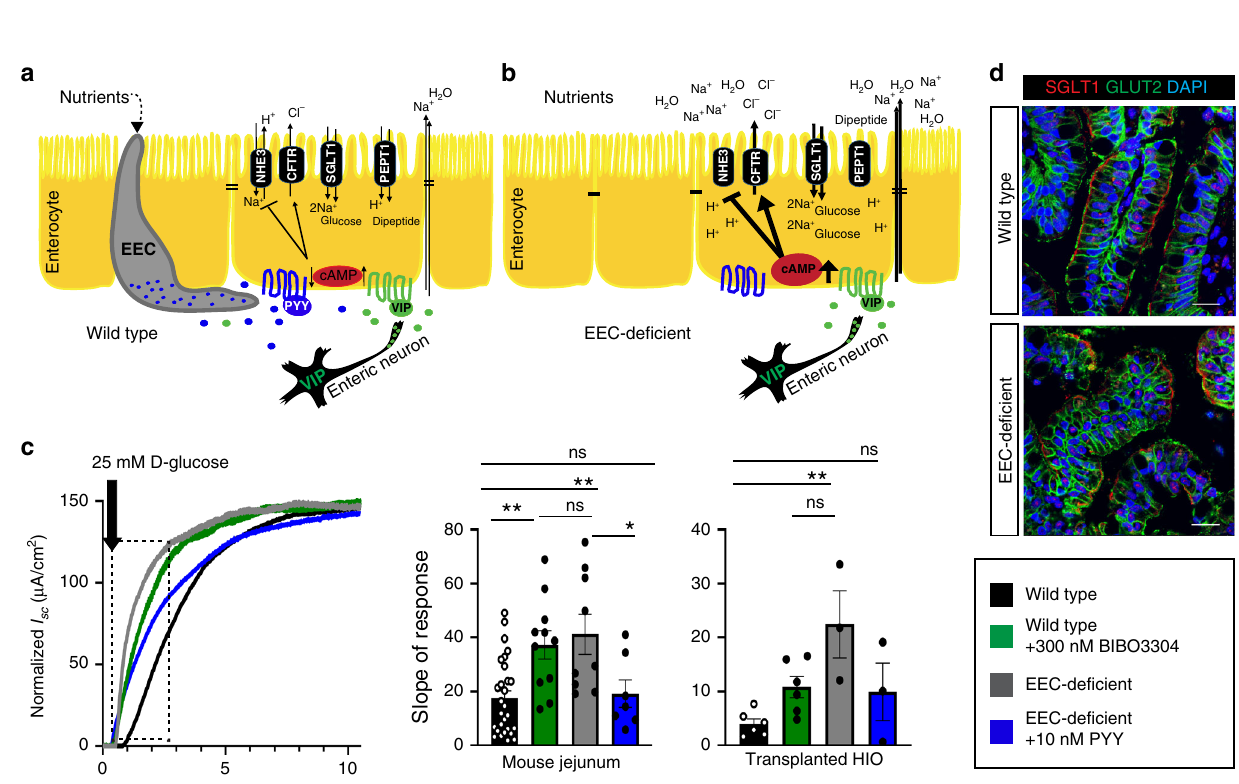
Fig. 1 The PYY-VIP axis regulates ion and water transport in mouse and human small intestine. a PYY and VIP regulate ion and water transport in HIO- derived small intestinal enteroids. VIP-induced ion and water transport as measured by enteroid swelling (**** P < 0.0001) in a CFTR-dependent manner. EEC-de fi cient enteroids had an elevated response to VIP compared to wild-type enteroids (* P = 0.04), which was inhibited in both cultures upon addition of PYY. Chemical inhibition of the PYY receptor NPY1R with BIBO3304 resulted in swelling of wild-type enteroids to EEC-de fi cient levels (**** P < 0.0001) and abolished the inhibitory effects of PYY in both genotypes (**** P < 0.0001). Scale bars = 500 μ m. n = 283 wild-type, n = 351 EEC-de fi cient enteroids over three biologically independent lines. Statistics calculated by two-way ANOVA with Sidak ’ s multiple comparisons test; upper row indicates comparison to vehicle; lower row indicates comparison between wild-type and EEC-de fi cient. b EEC-de fi cient enteroids displayed impaired NHE3 activity. Quanti fi cation is of initial rate of Na + -dependent intracellular pH recovery (red line) after acid load using the ratiometric pH indicator SNARF-4F. n = 16 wild-type, n = 18 EEC-de fi cient enteroids; * P = 0.01; statistics calculated by unpaired, two-tailed Student ’ s t test. c The localization of VIPR1 and NPY1R was comparable between wild-type and EEC-de fi cient human intestinal epithelium. PYY + and CHGA + cells were only found in wild-type HIOs. Scale bars = 50 μ m. Representative images from four independent organoids are shown. d PYY modulates the stimulatory effects of VIP in mouse and human small intestine. Using an Ussing chamber we observed EEC-de fi cient small intestinal tissue displayed a greater response ( Δ I sc ) to 10 nM VIP than wild-type (mouse, n = 20 wild-type, 8 mutant, **** P < 0.0001; human, n = 15 wild-type, 9 mutant, ** P = 0.001). Inhibition of NPY1R in wild-type tissue with BIBO3304 resulted in an elevated response to VIP (mouse, n = 24, * P = 0.01; human, n = 7, * P = 0.04), whereas addition of exogenous PYY reduced the magnitude of EEC-de fi cient response to VIP ( n = 8 mutant mice, **** P < 0.0001; n = 7 mutant HIOs, ** P = 0.007) to wild-type levels. Electrogenic responses to VIP were blocked by the CFTR inhibitor CFTR-172 (dotted lines). One representative trace is shown (mouse), with baseline I sc normalized to 0 μ A/cm 2 . Statistics calculated by one-way ANOVA with Tukey ’ s multiple comparisons test. All error bars are + SEM.